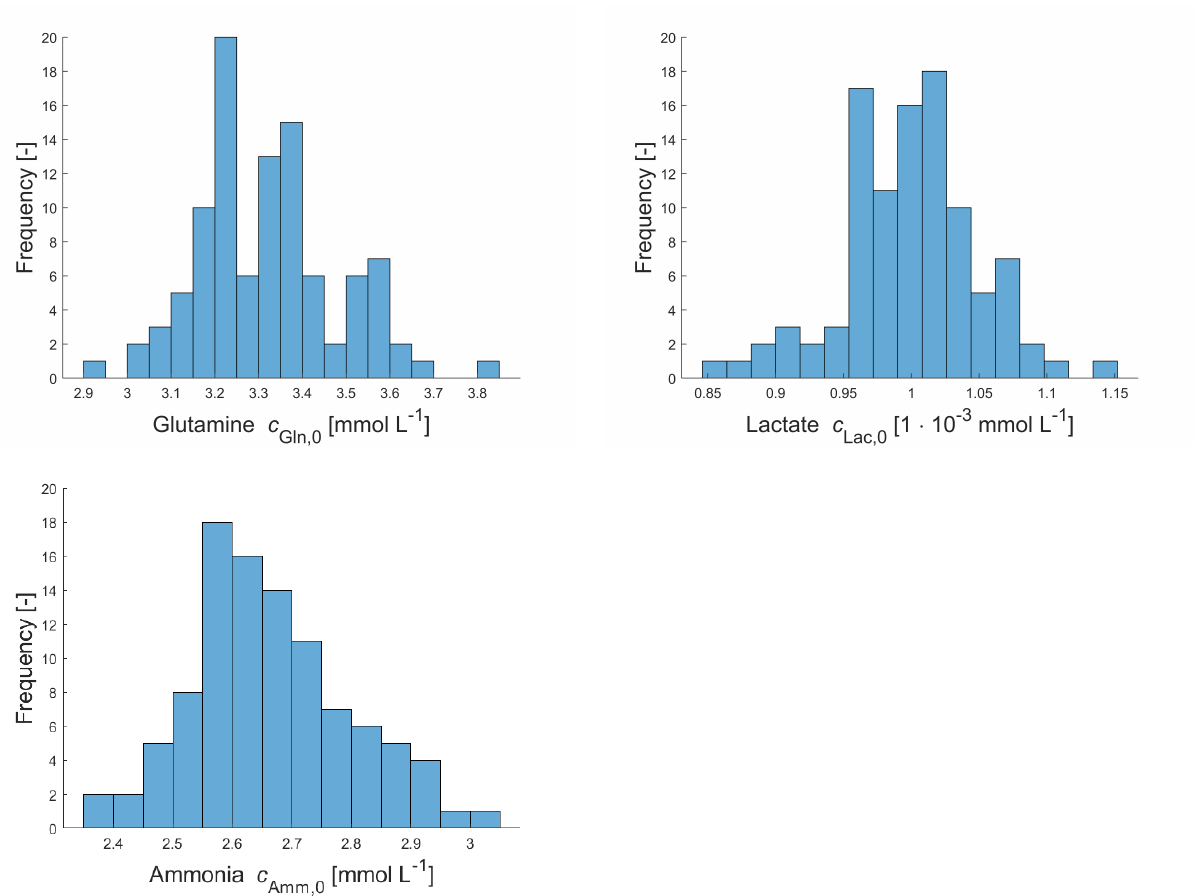
Figure A1. Histograms of sampled initial concentrations of viable cells X v0 , glucose c Glc , glutamine c Gln , lactate c Lac and ammonia c Amm in the first cultivation vessel for upstream simulations.